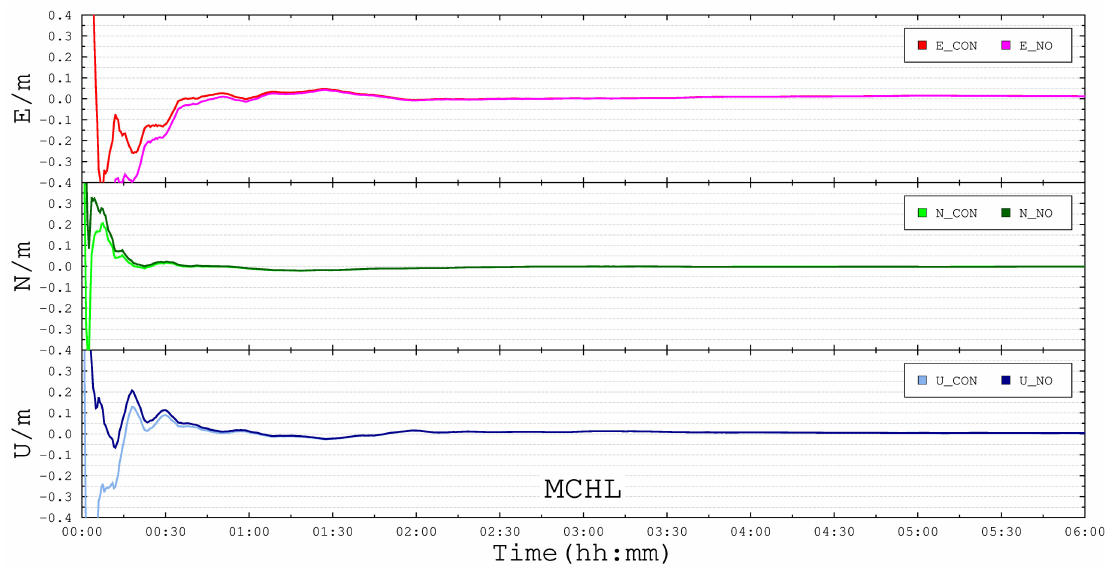
Figure 17. The static precise point positioning (PPP) solutions of station MCHL at DOY 097,